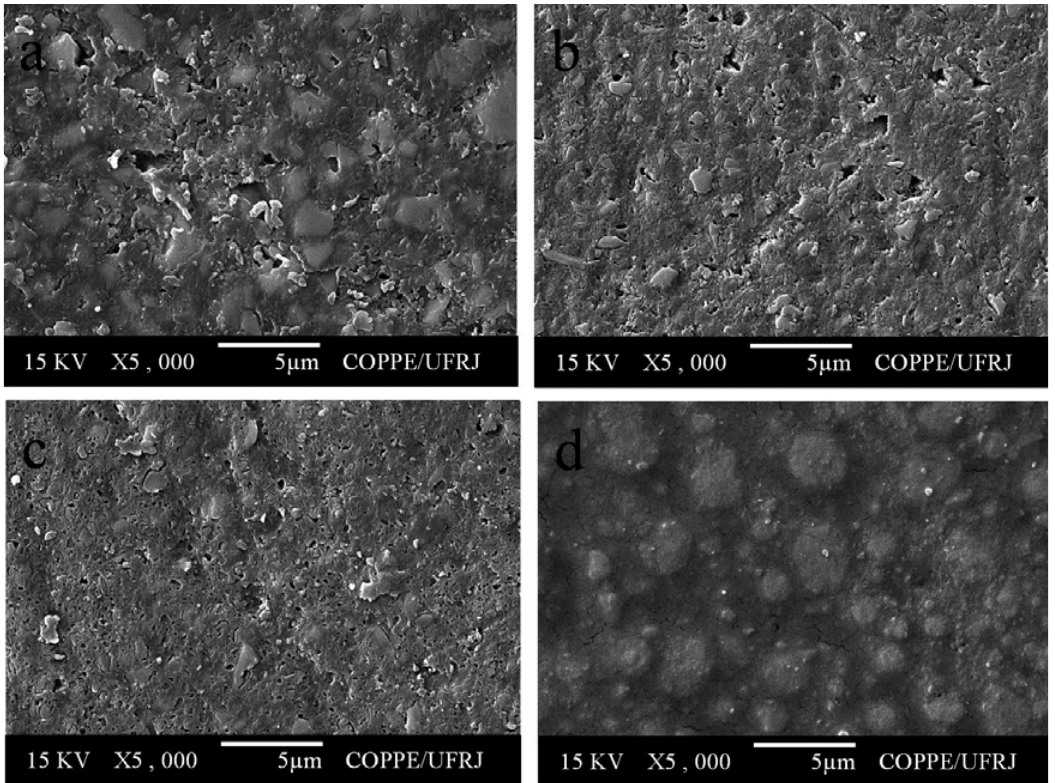
FIGURE 4- Representative SEM photomicrographs of resin-based composites after pH-cycling and immersion in distilled water, control group. (a) TPH, (b) Concept, (c) Opallis and (d)